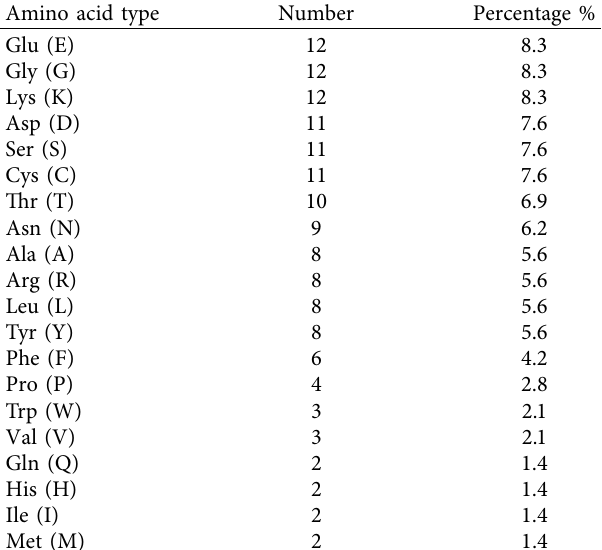
Table 3. According to the PeptideCutter web server, the prediction enzymes including caspase-1 to − 10, enteroki- nase, factor Xa, granzymeB, and thrombin cannot cut Maurolipin coding sequence.